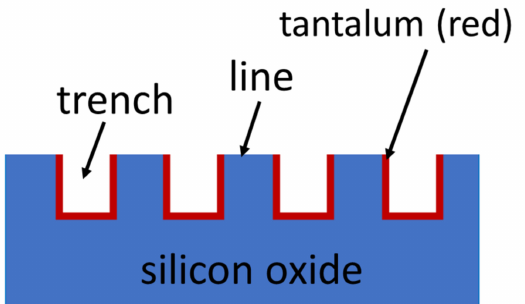
Figure 1. Schematic cross-section drawing of the parallel line/trench structures tested in this work. The trench sidewall and bottom surfaces are covered with a tantalum thin film where the silicon oxide is exposed on the top surface. Line and trench widths are